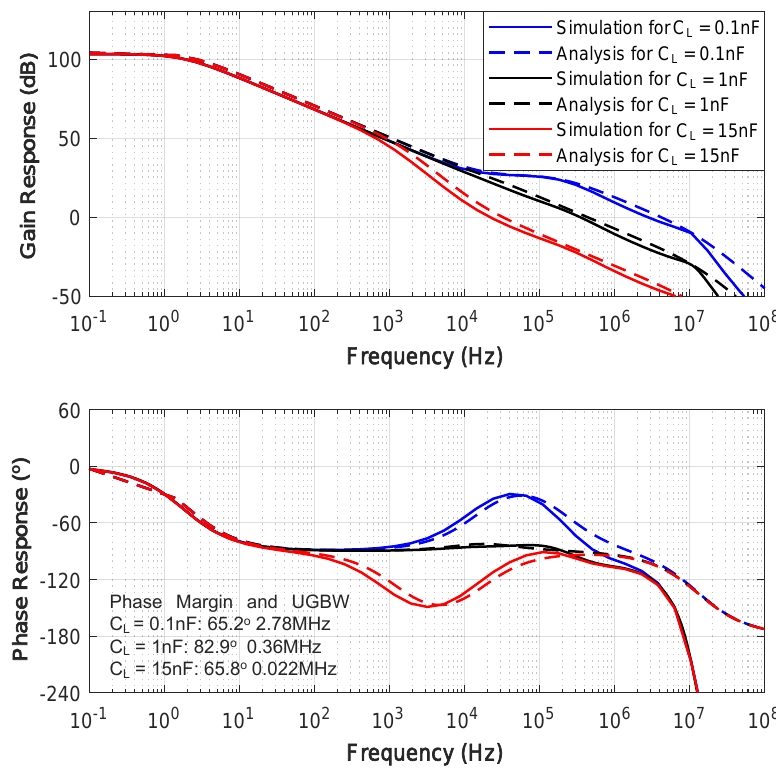
Figure 13. Simulated frequency response of the proposed amplifier with 0.1-nF, 1-nF and 15-nF load capacitance.